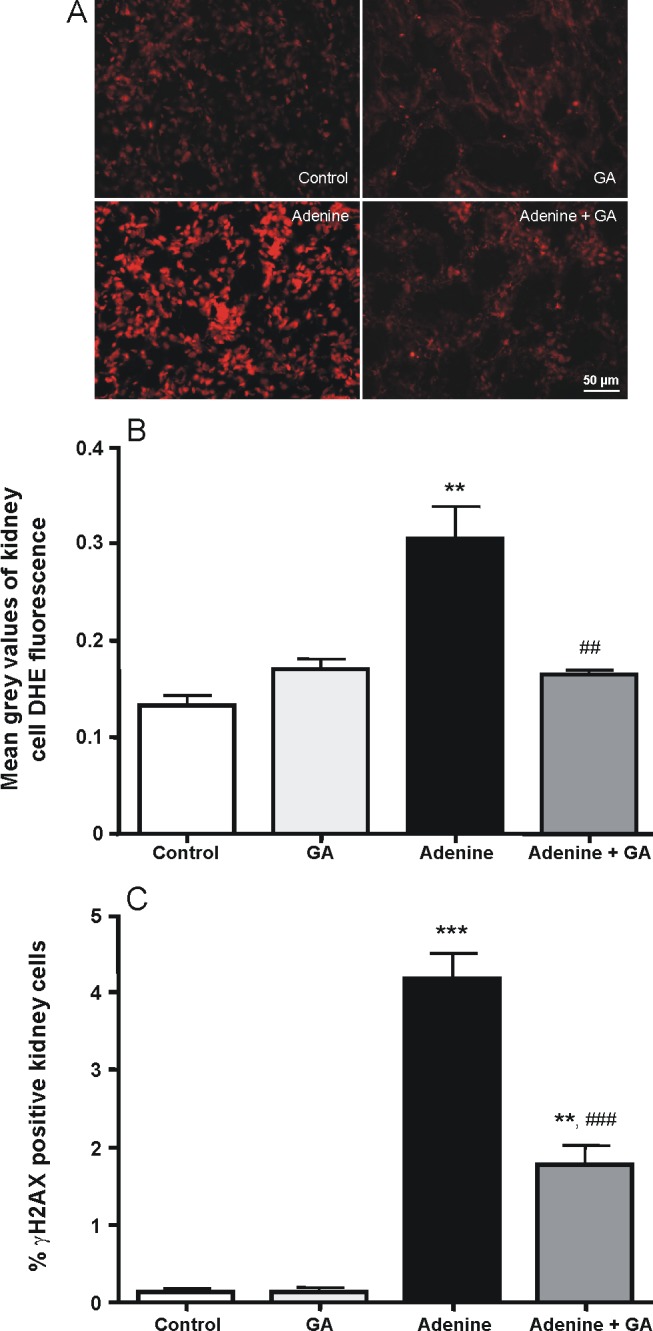
Representative pictures of superoxide formation visualized by using the dye dihydroethidium on kidney cryosections (A). Superoxide (B) and DNA double strand break formation (C) in control rats, rats treated with gum arabic (15% w/v in drinking water) and rats treated with adenine (0.75% w/w) alone in feed, or with adenine and gum arabic given concomitantly at the same dose for 28 days.Each column and vertical bar represents the mean ± SEM (n = 5). ** p<0.01, *** p<0.001 vs. control, ## p<0.01, ### p<0.001 vs. adenine treatment.